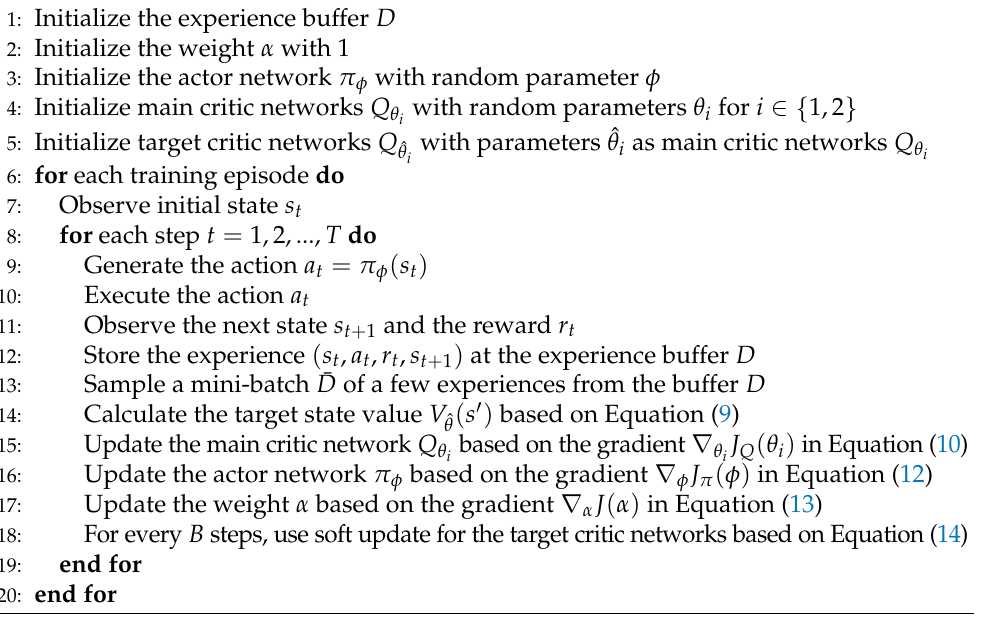
Algorithm 1 Discretized soft-actor-critic